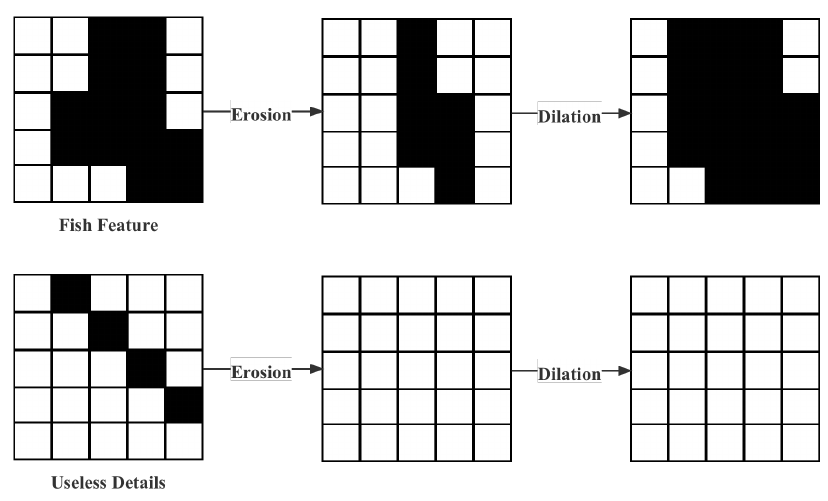
Figure 4. Processing of removal of useless details.